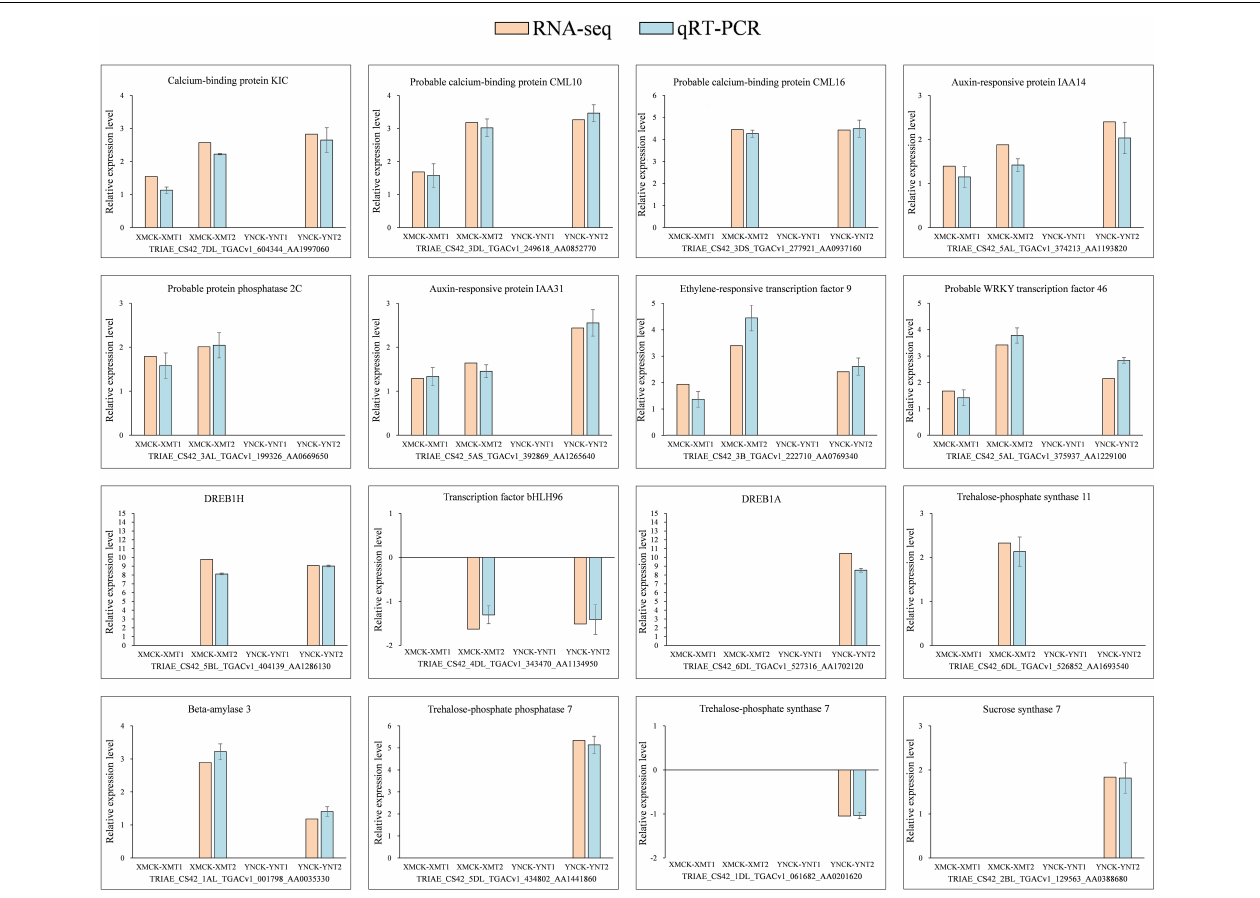
FIGURE 6 | Expression validation of 16 selected DEGs. The relative expression levels of 16 DEGs were determined using qRT-PCR at 4 ◦ C and − 4 ◦ C. There were 14 upregulated genes and two downregulated genes, with three biological replications and three technical replications for each. Relative expression levels were calculated by log 2 2 − (cid:49)(cid:49) Ct method and log 2 FC (RNA-seq). Here, Y -axis indicates relative expression levels and X -axis indicates each comparison group (XMCK-XMT1, XMCK-XMT2, YNCK-YNT1, YNCK-YNT2). An empty histogram indicates either RNA-seq could not detect the gene under this treatment or its expression level was low by | log 2 (foldchange)| < 1. XMCK, Xinmai26 was treated at 16 ◦ C; XMT1, Xinmai26 was treated at 4 ◦ C for 4 h; XMT2, Xinmai26 was treated at − 4 ◦ C for 4 h; YNCK, Yannong19 was treated at 16 ◦ C; YNT1, Yannong19 was treated at 4 ◦ C for 4 h; YNT2, Yannong19 was treated at − 4 ◦ C for 4